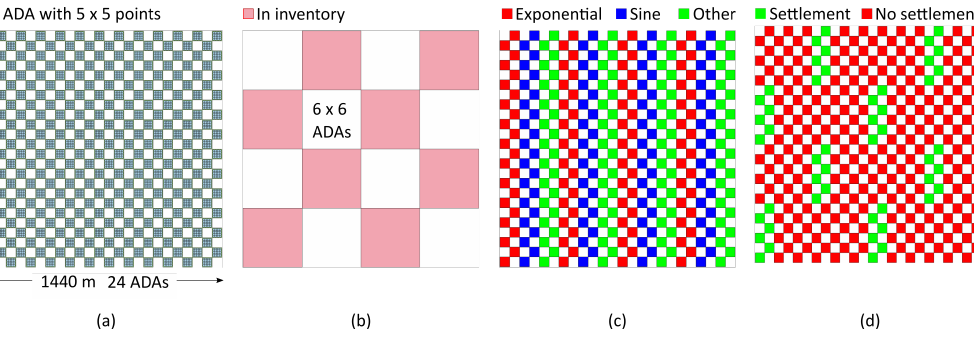
Figure 3. Synthetic dataset to check the consolidation process: ( a ) ADAs distributed in a 24 × 24 checkerboard pattern. ( b ) Infrastructures inventory. ( c ) Kind of deformation time series for each ADA. ( d ) Results of the classification